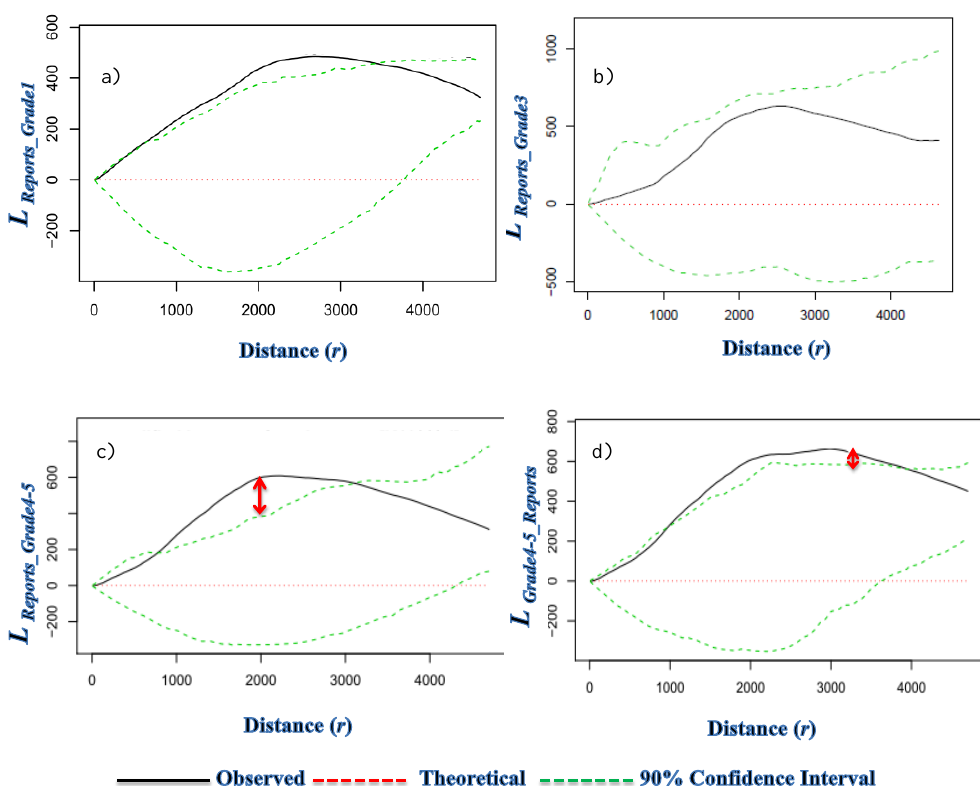
Figure 5. Cross L-functions L ij with i = crisis reports, j = damage grade 1 (a) i = crisis reports, j = damage grade 3 (b) i = crisis reports, j = damage grades 4 and 5, (d) Cross L-functions L ji with j = damage grades 4 and 5, i = crisis reports, with envelopes computed under the hypothesis of independence of populations. The red arrows indicate the magnitude of the significant attraction for a given distance.